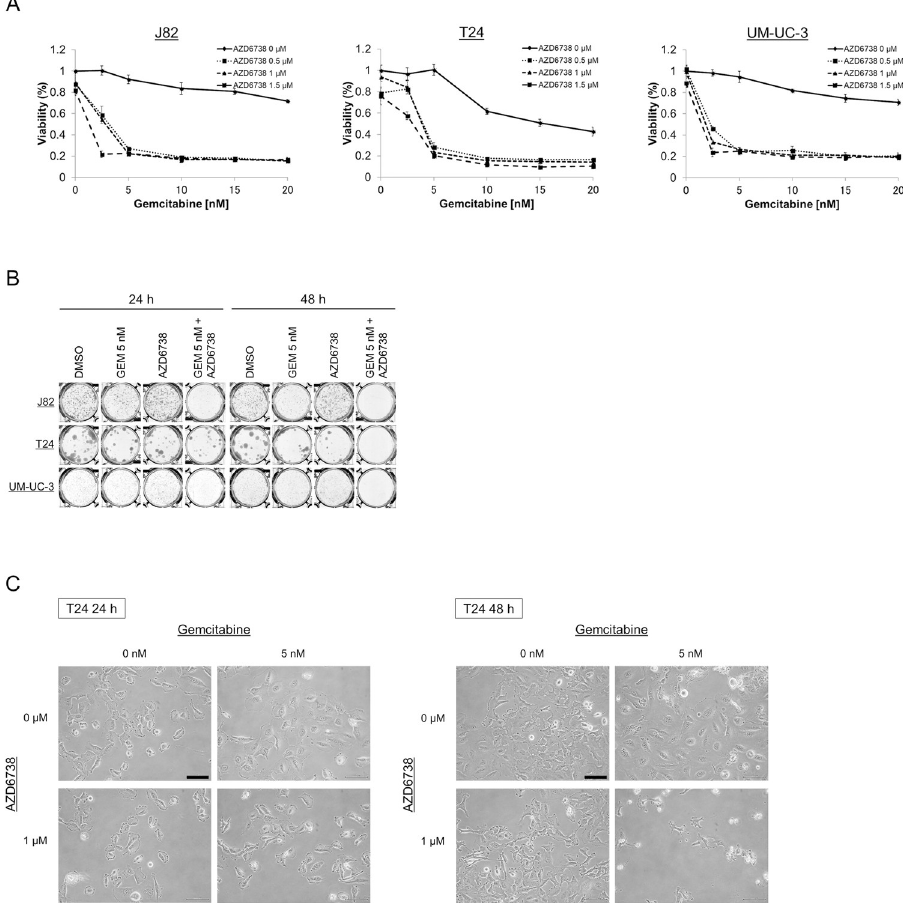
Fig 1. Viability and clonogenicity of bladder cancer cells after treatment with gemcitabine and/or AZD6738. (A) Relative viability in bladder cancer cells (J82, T24, and UM-UM-3) was measured using the MTS assay (mean ± SD, n = 4) after 48 h of treatment with gemcitabine and/or AZD6738. (B) Clonogenicity assay following 24 and 48 h of treatment with gemcitabine, AZD6738, or both compounds compared to DMSO solvent control. GEM stands for gemcitabine. The concentration of AZD6738 is 1 μ M. (C) Photomicrographs showing characteristic morphological changes in T24 cells treated with gemcitabine and AZD6738 (24 and 48 h). Scale bar = 100 μ